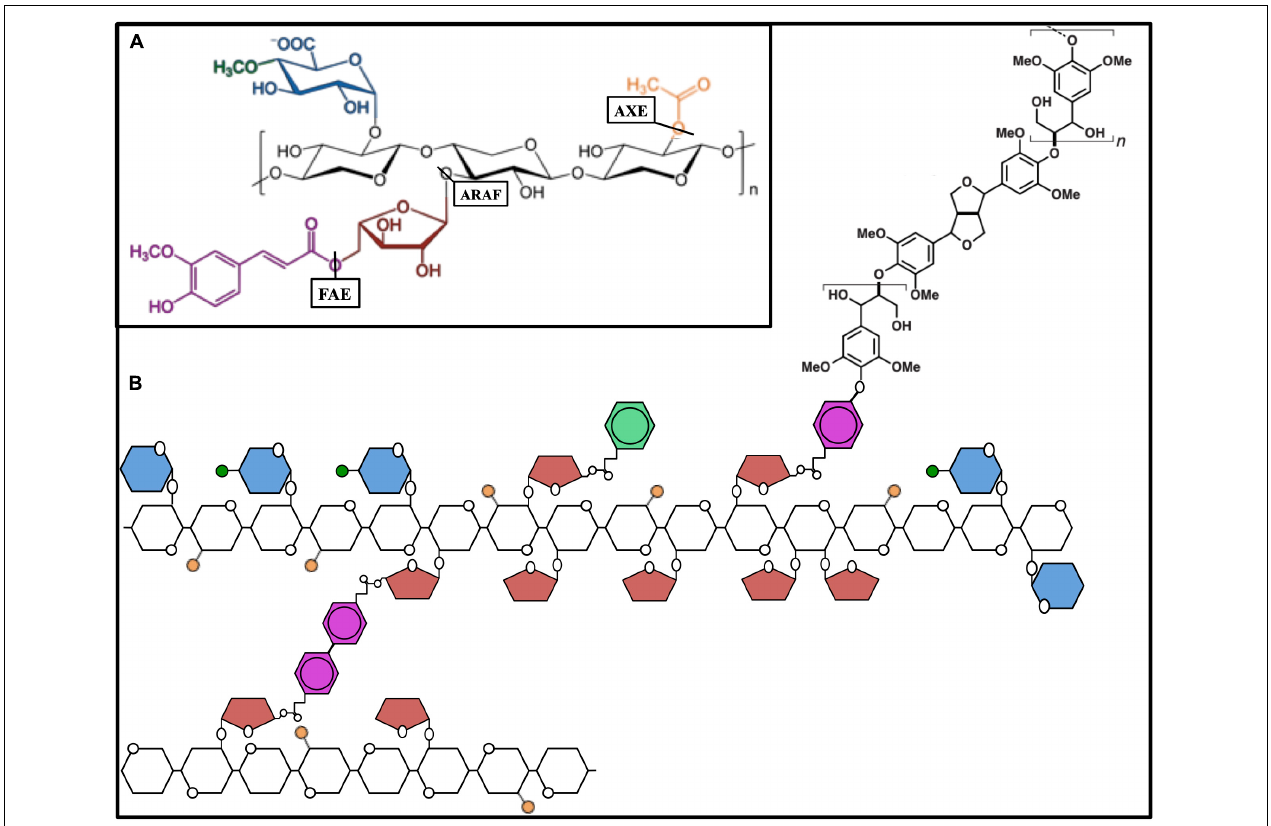
FIGURE 3 | The hemicellulose xylan and interactions. (A) Schematic molecular structure of xylan module with β -(1,4)-linked xylose residues (black) of the xylan backbone that are substituted with acetyl (orange), arabinose (red), and glucuronic acid (blue) residues. Arabinose is partially esterified with ferulic acid (magenta) and glucuronic acid is often 4- O -methylated (green). Acetyl xylan esterase (AXE), arabinofuranosidase (ARAF), and ferulic acid esterase (FAE) indicating the bonds they hydrolyze. (B) Schematic representation of the xylan chain, xylan-xylan diferulate cross-linking, and ferulic acid-mediated lignin